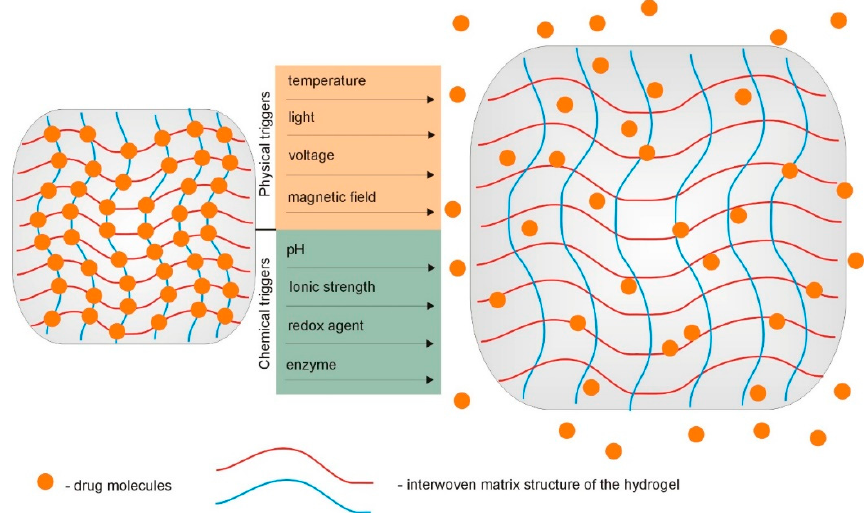
Figure 6. Hydrogel-based implantable therapeutic carriers for local therapy operate as swelling- controlled systems in response to various chemical and physical triggers.